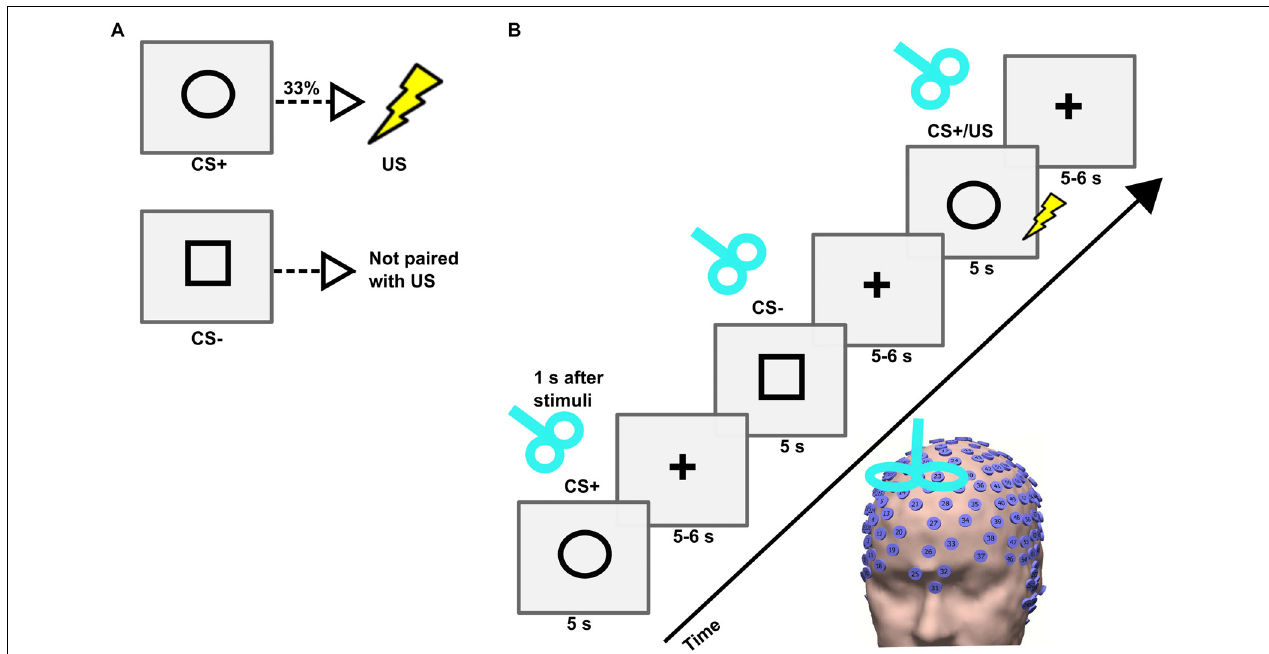
FIGURE 1 | (A) Conditioned stimulus (CS+), unconditioned stimulus (US), and neutral stimulus (CS–) and their contingencies in an instructed fear paradigm. (B) Trial sequence in the TMS experiment. Each trial consisted of the presentation of a stimulus (CS+ or CS–) followed by a fixation cross. The stimulus was presented on a computer screen for 5 s followed by a fixation cross that jittered between 5 and 6 s. A single-pulse TMS was applied on the right dorsomedial prefrontal cortex (dmPFC) 1 s after the onset of each